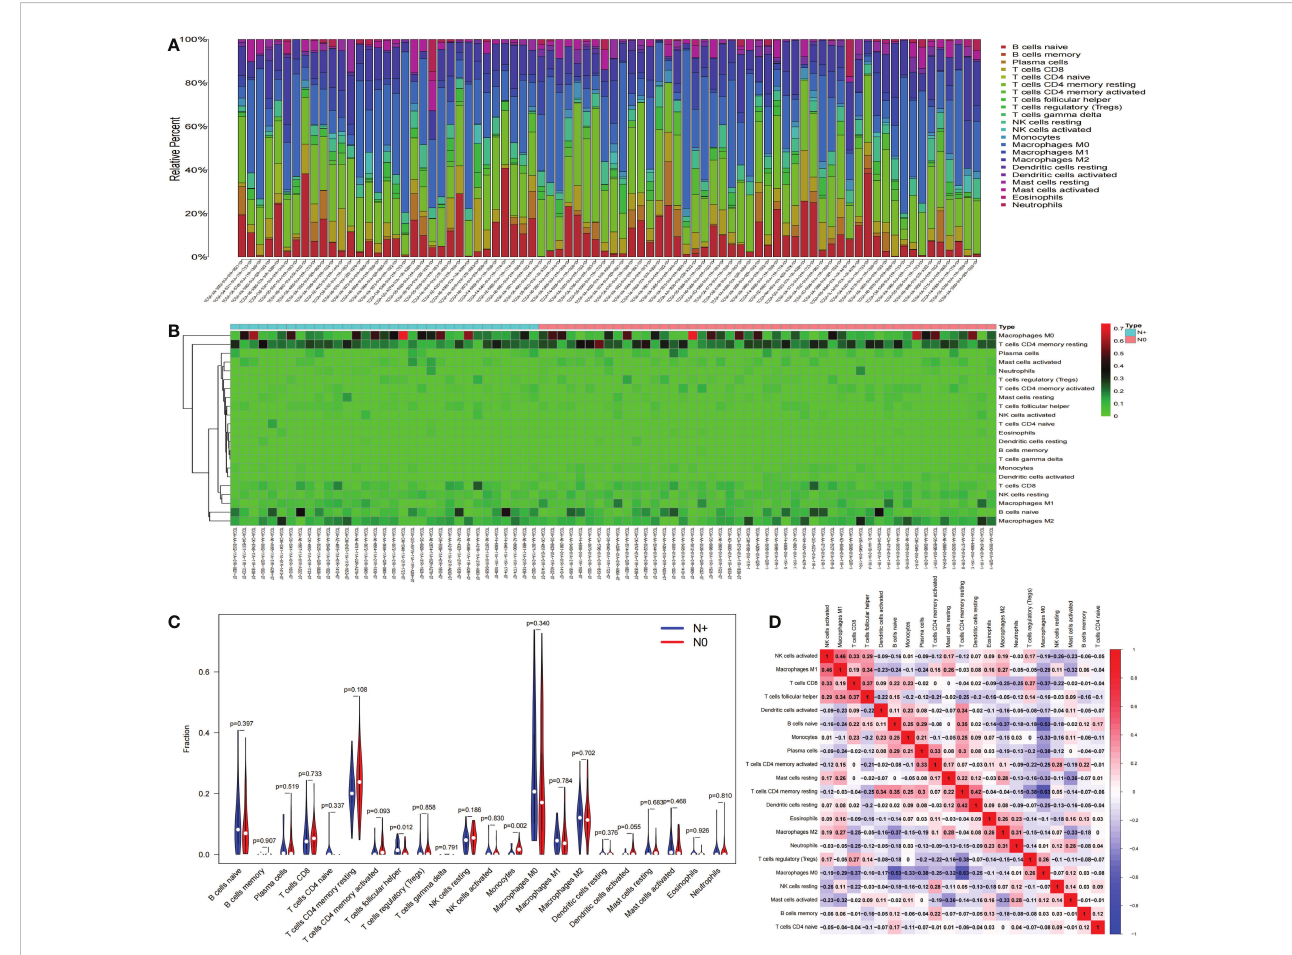
FIGURE 4 Immune cell in fi ltration. The composition of immune cells was assessed by the CIBERSORT algorithm in COAD (A, B) . The proportions of T follicular helper cells and monocytes were different in N+ and N0 group tissues (C) . The results of the correlation analysis of immune in fi ltrating cells are shown as a heatmap (D) . CIBERSORT, cell-type identi fi cation by estimating relative subsets of RNA transcripts; COAD, colon adenocarcinoma.